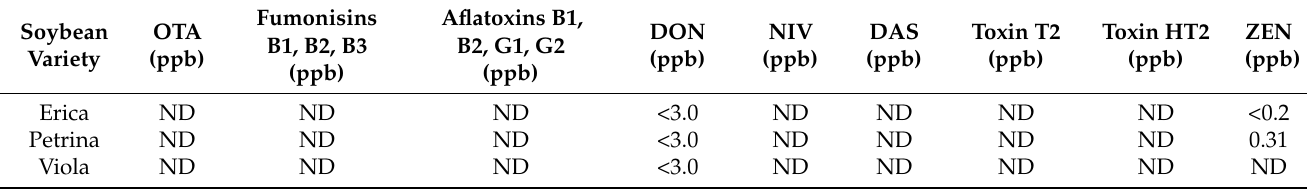
Table 3 lists the content of individual mycotoxins in the soybean seeds. None of the varieties contained ochratoxin, fumonisins, aflatoxins, nivalenol, diacetoxyscirpenol, T2 or There were trace amounts of zearalenone only in the Erica and Petrina soybean seeds. Table 3. The content of mycotoxins in the soybean seeds.